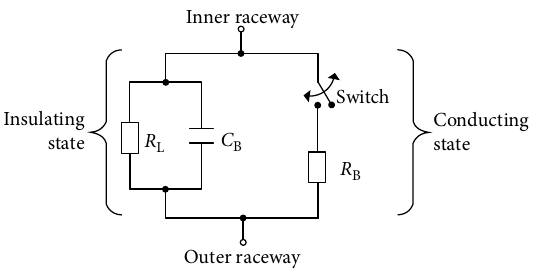
Figure 1: Equivalent electrical circuit model of a steel bearing. The left branch shows the insulating state; the right branch shows the conducting